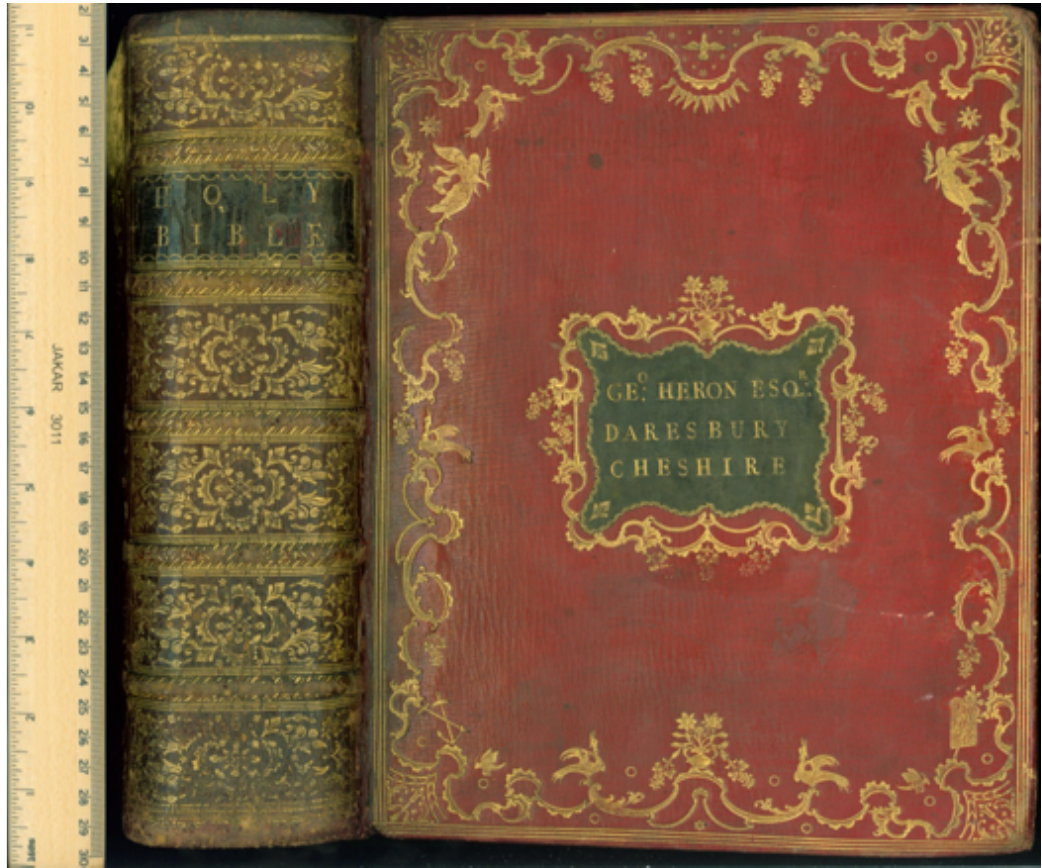
Fig. 23. The Holy Bible, etc. (London, 1767). This is finished with the same tools used by Kenrick Peck’s binder. BL,